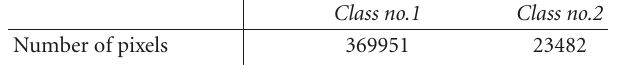
Figure 2: Class no.1 (grass) : PoE of D for the real data and for the theoretical